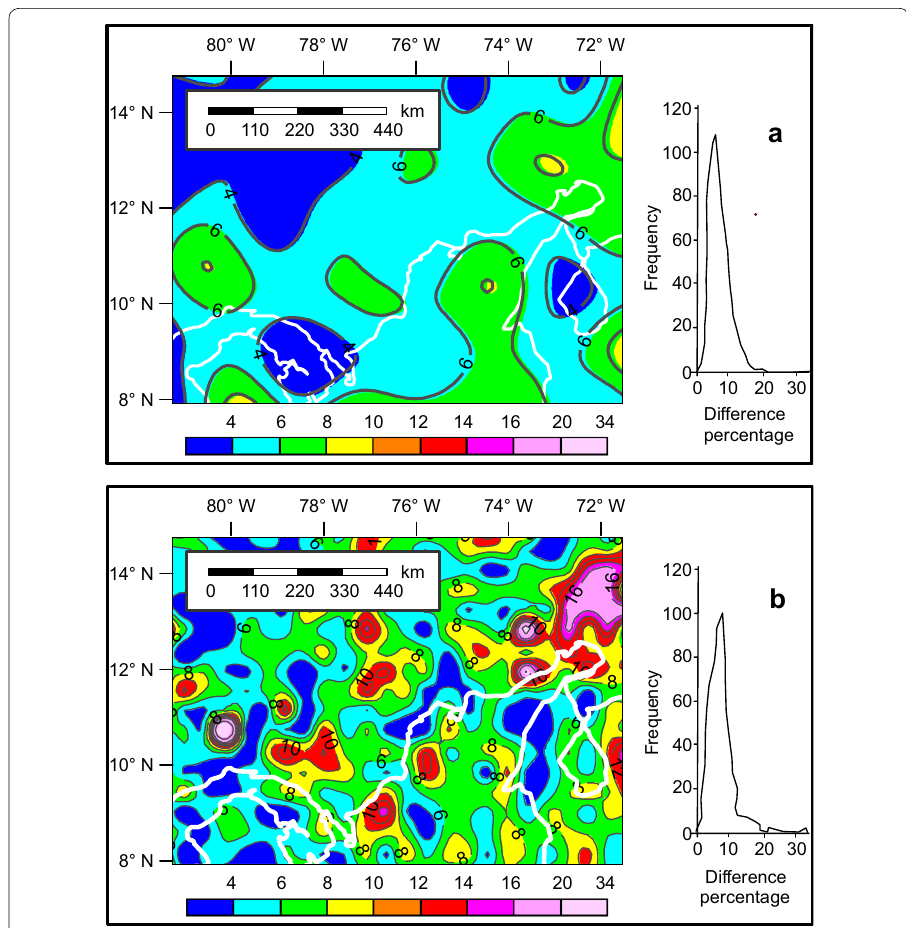
Fig. 5 Differences in percentage between Curie Point Depth estimations by the fractal and centroid methods. a Differences corresponding to the fractal method range between 4 and 6%. b Distribution corresponding to the centroid method. It presents several maximums with differences between 20 and